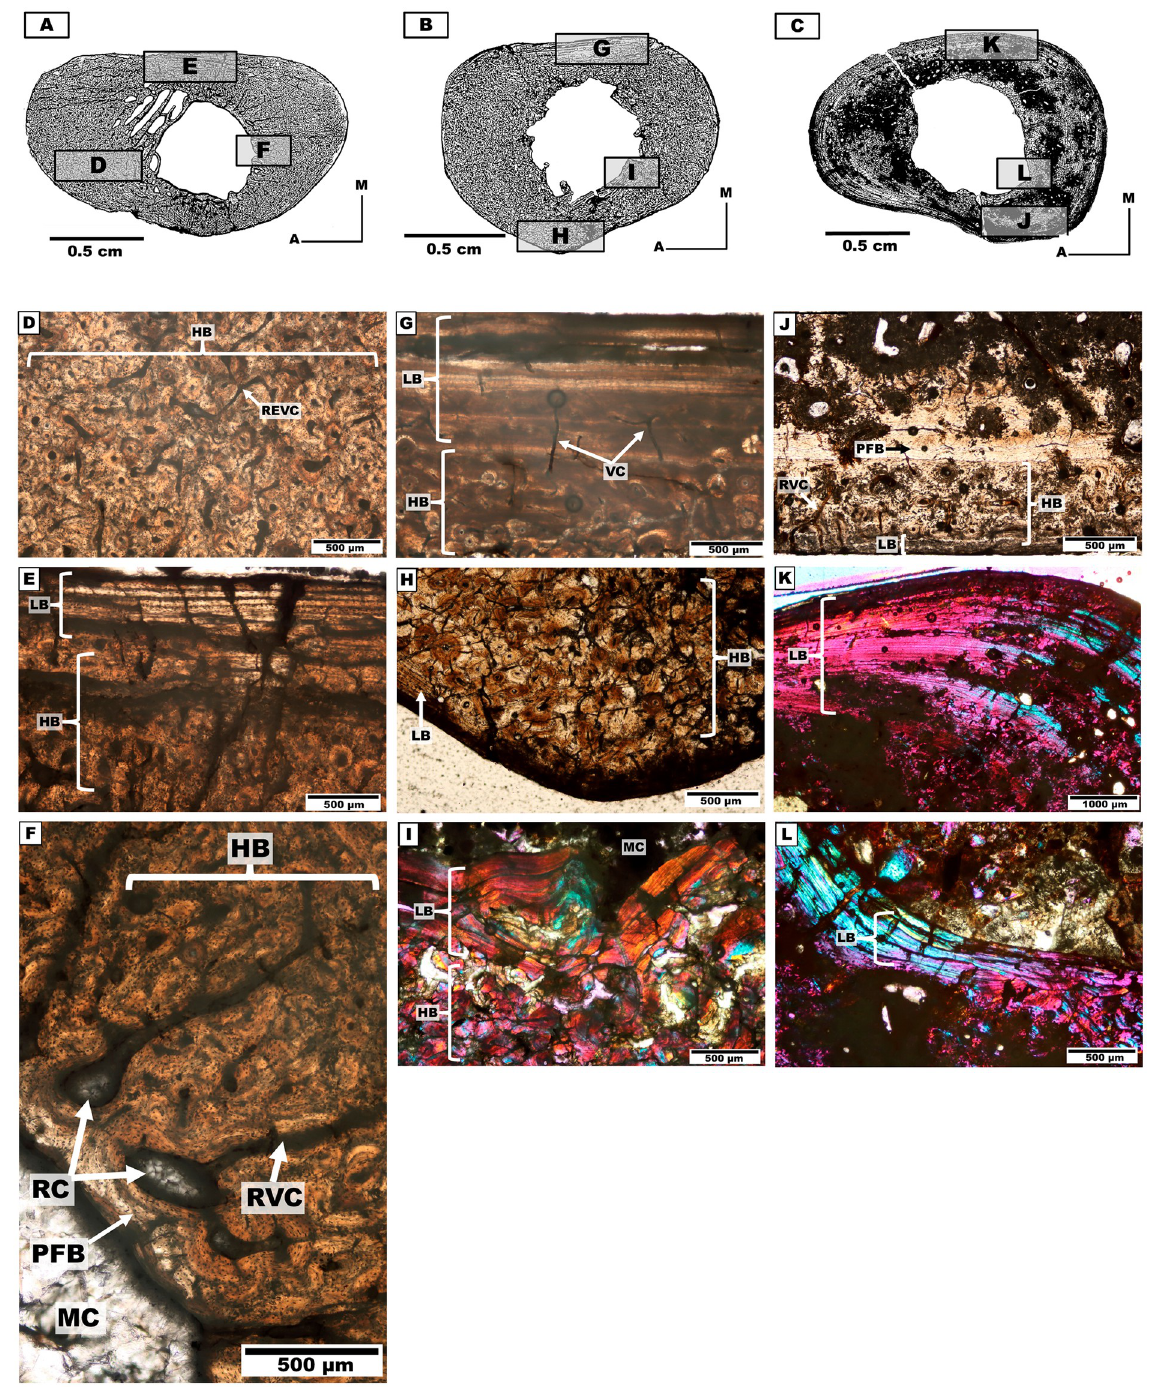
Fig 9. Tibia cross-sections of the mesotheriine notoungulate Caraguatypotherium munozi from the middle Miocene of Caragua, Huaylas formation. (A) Tibia cross-section for individual 4 (GEOUACH.HS.TI.1); (B) Tibia cross-section for individual 5 (GEOUACH.HS.TI.2); (C) Tibia cross section for individual 6 (GEOUACH.HS.TI.3); (D) HB in the intracortical region and presence of REVC (GEOUACH.HS.TI.1); (E) LB in the pericortical region and HB in the intracortical region (GEOUACH.HS.TI.1); (F) PFB in the endocortical region and RC (GEOUACH. HS.TI.1); (G) LB in the pericortical region, presence of VC and HB in the intracortical region (GEOUACH.HS.TI.2); (H) HB in the intracortical region; LB in the pericortical region (GEOUACH.HS.TI.2); (I) LB in the endocortical region and HB in the endocortical region (GEOUACH.HS. TI.2); (J) LB in the pericortical region, PFB in the interstitial spaces in the endocortical region (GEOUACH.HS.TI.3); (K) LB in the pericortial region and intracortical region (GEOUACH.HS.TI.3); (L) LB in the endocortical region (GEOUACH.HS.TI.3). For abbreviations refer to Fig 4.